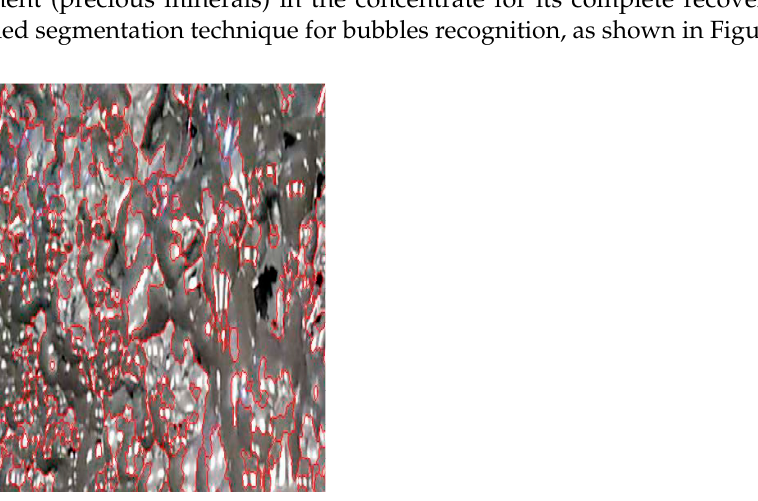
Figure 10. Example of segmentation results using watershed algorithm (Reprinted from Ref. [106]).